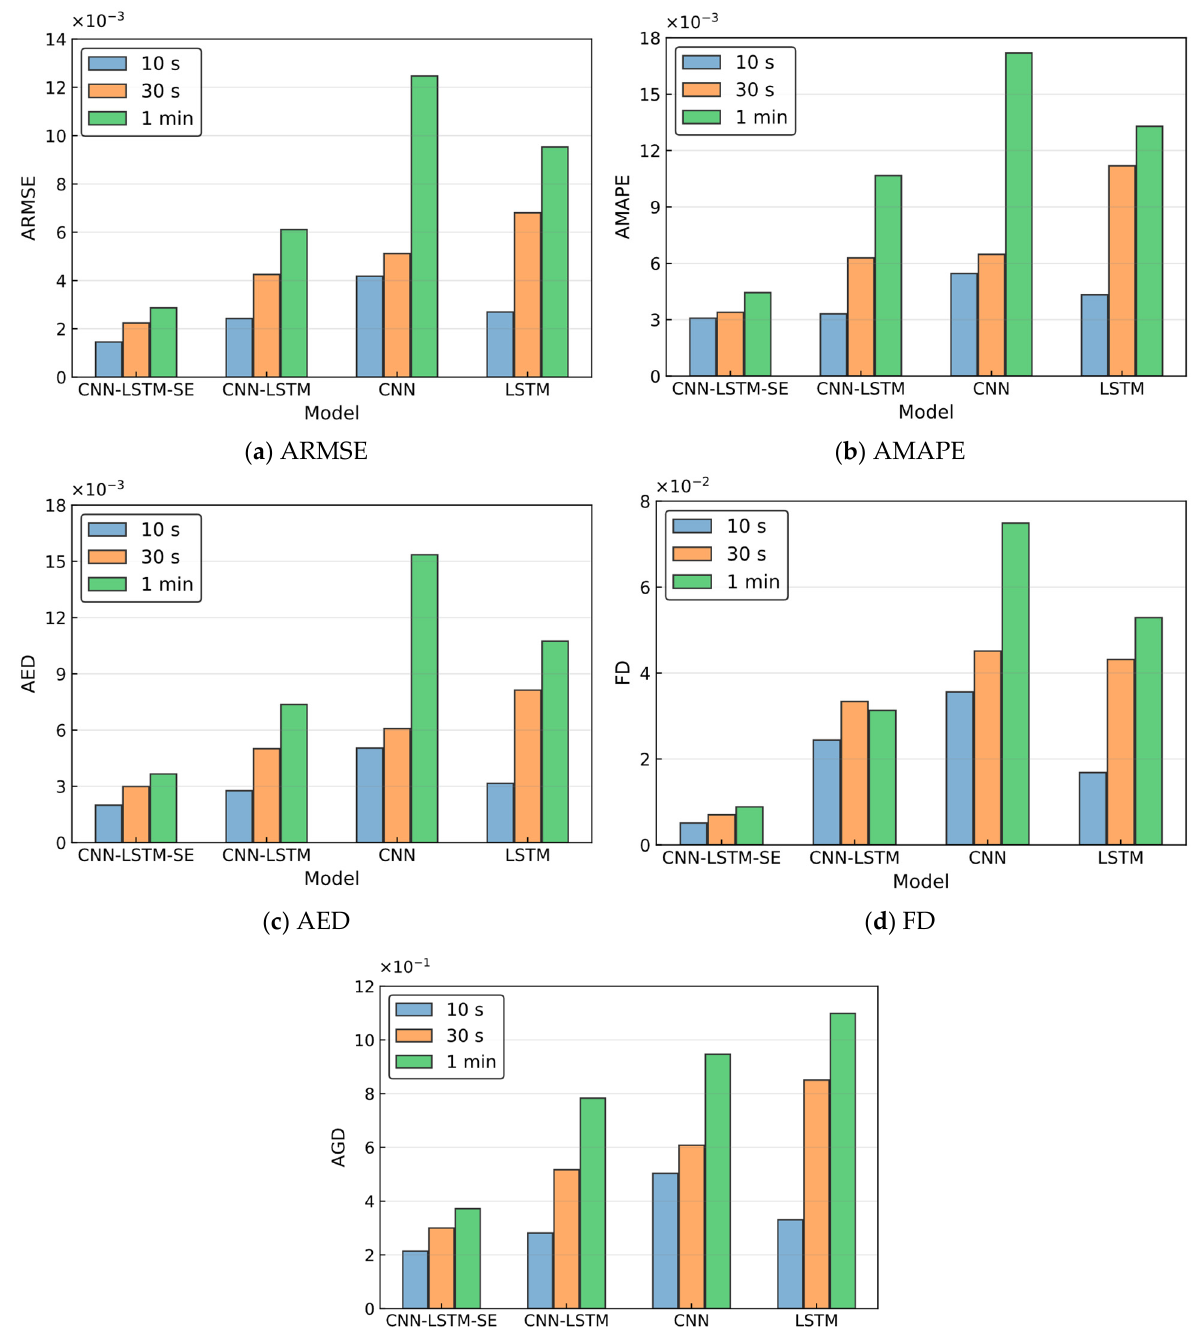
Figure 5. Distribution of evaluation indexes of ship-1.